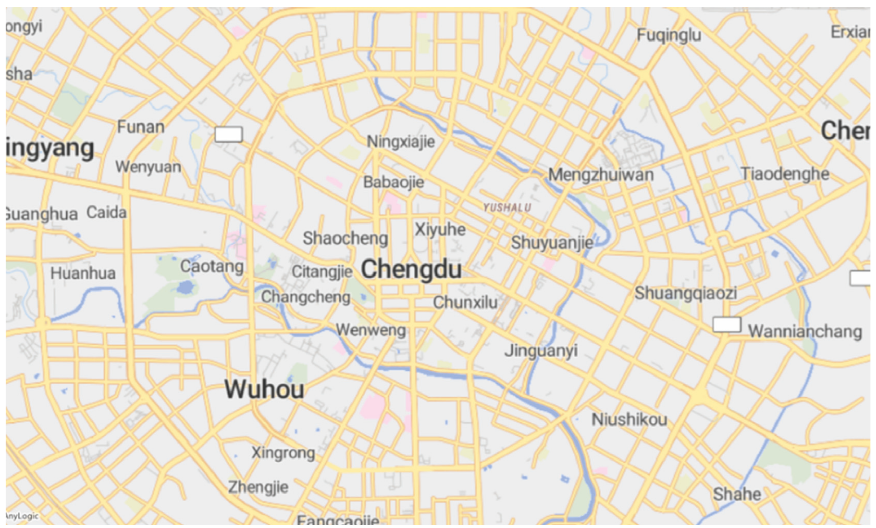
Figure 5: Simulated experimental area.